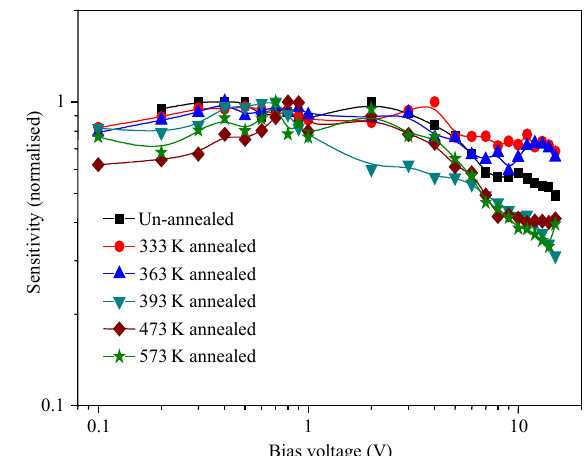
Fig. 5 Detection sensitivity of an un-annealed and 333 K, 363 K, 393 K, 473 K, and 573 K annealed films against the bias